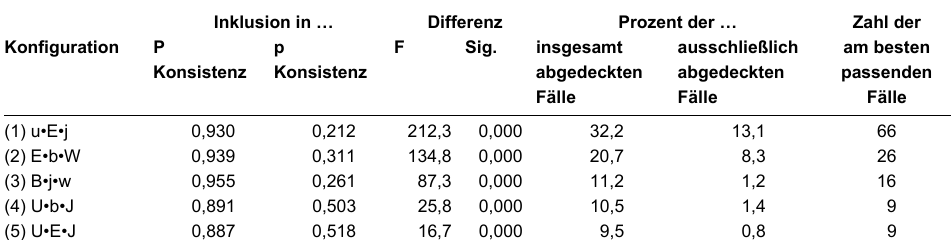
Tabelle 4 : Test der reduzierten Konfigurationen auf Fuzzy-Inklusion mit hoher